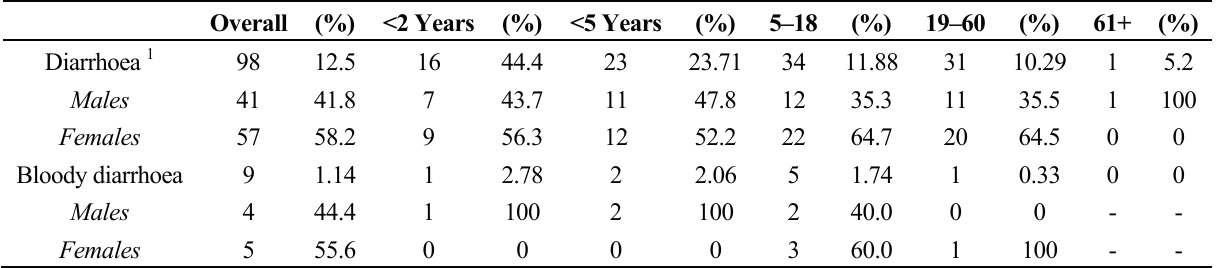
Number of different ethnic groups reported Table 2. Number and percentage of individuals who reported gastrointestinal illness symptom(s) during the health survey; overall, and by age class and gender. Overall Diarrhoea